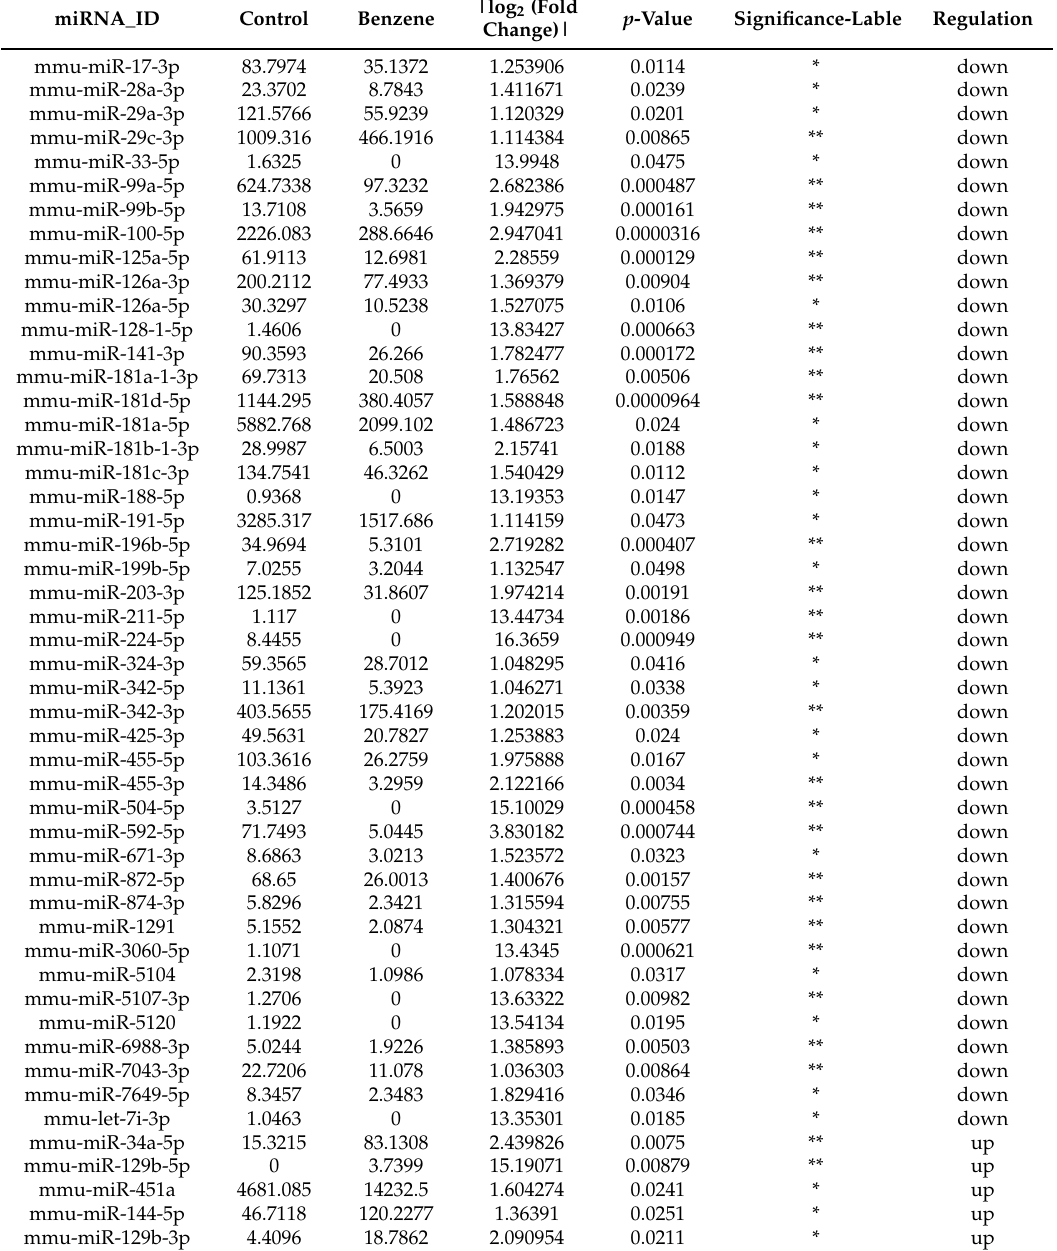
Table 4. Aberrant miRNAs profile of Lin ´ cells expressed between benzene exposure group and the control